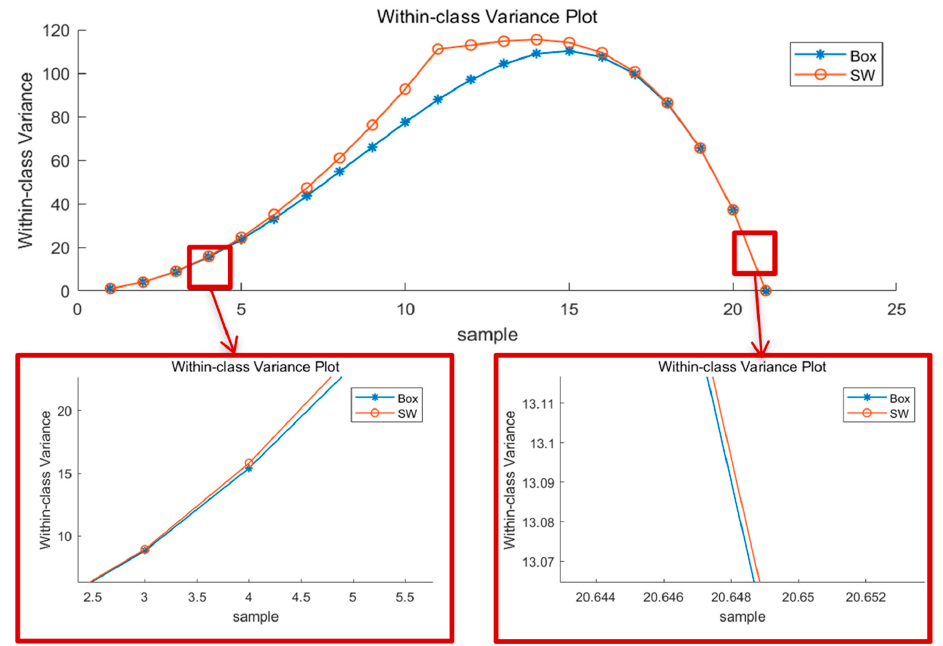
Figure 8. Within-class variance of test images binarized by SW and Box.